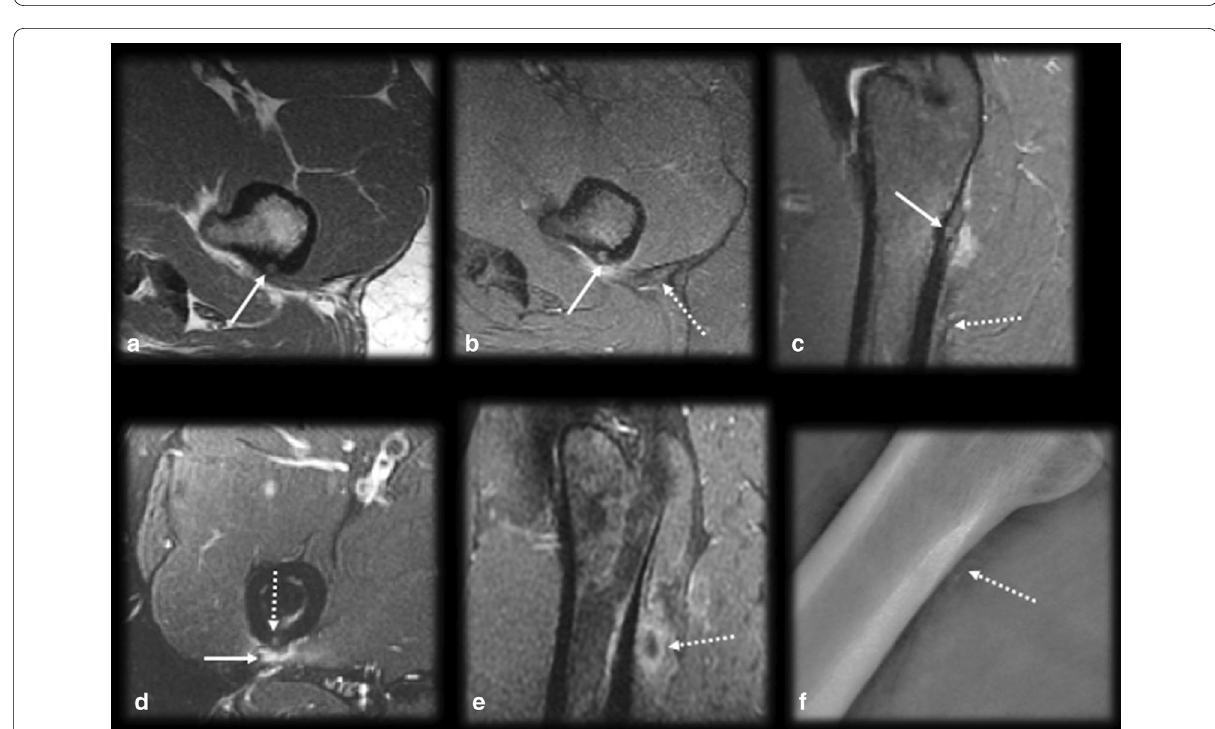
Fig. 13 Osteoid osteoma versus crystal deposition disease [2]. ( a – c ) Male, 30 years old, presenting with posterior thigh pain for 3 months. Axial T1 ( a ) and axial ( b ) and sagittal ( c ) T2 FS MRI demonstrated a cortical nidus (arrows) and reactional bone marrow edema close to the gluteus tuberosity. Note that the gluteus maximus tendon (dotted arrow) insertion is below the nidus. ( d – f ) Female, 38 years old, presenting with very intense posterior thigh pain for 2 days. T2 FS axial and coronal MRI ( d , e ) and plain radiograph ( f ) showed corticoperiosteal and bone marrow edema in the right gluteus maximus tendon (arrows) insertion and some calcifications (dotted